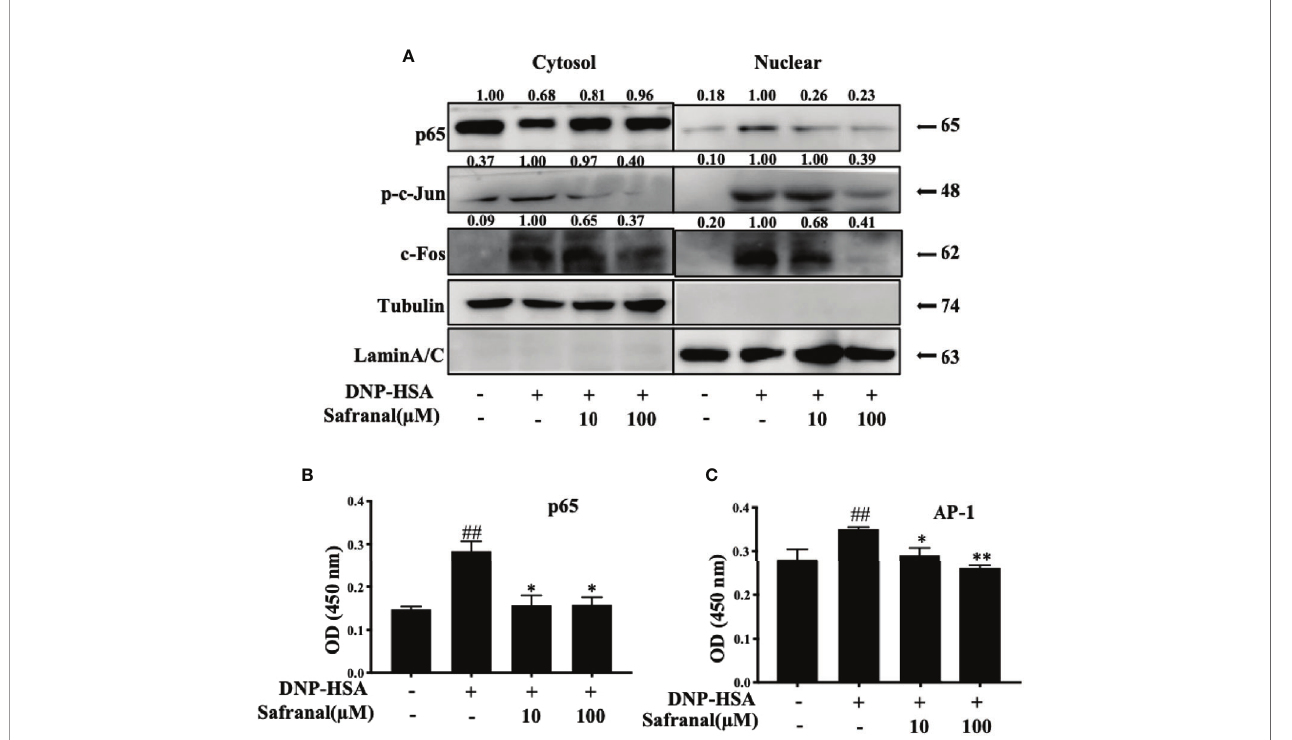
FIGURE 8 | Safranal inhibited the nuclear translocation of NF- k B, AP-1. (A) BMMCs were collected after incubation with safranal and stimulation of DNP-HSA. Transcriptional factors p65, p-c-jun, and c-Fos in cytoplasmic or nuclear extracts were determined using western blot. (B, C) Nuclear transcriptional factors binding activity of p65, and AP-1 were determined by Trans AM kit, the result present in OD value. The data shown are representative of three independent experiments and indicate the means ± S.E.M. ## p <0.01 compared to nontreated group, * p <0.05, ** p <0.01 compared to DNP-HSA.